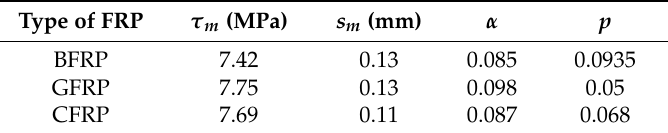
Figure 16. Bond-slip test for deep embedment FRP bars and concrete: ( a ) Test specimen; ( b ) Test results. Table 4. The coefficients for bond-slip constitutive model.